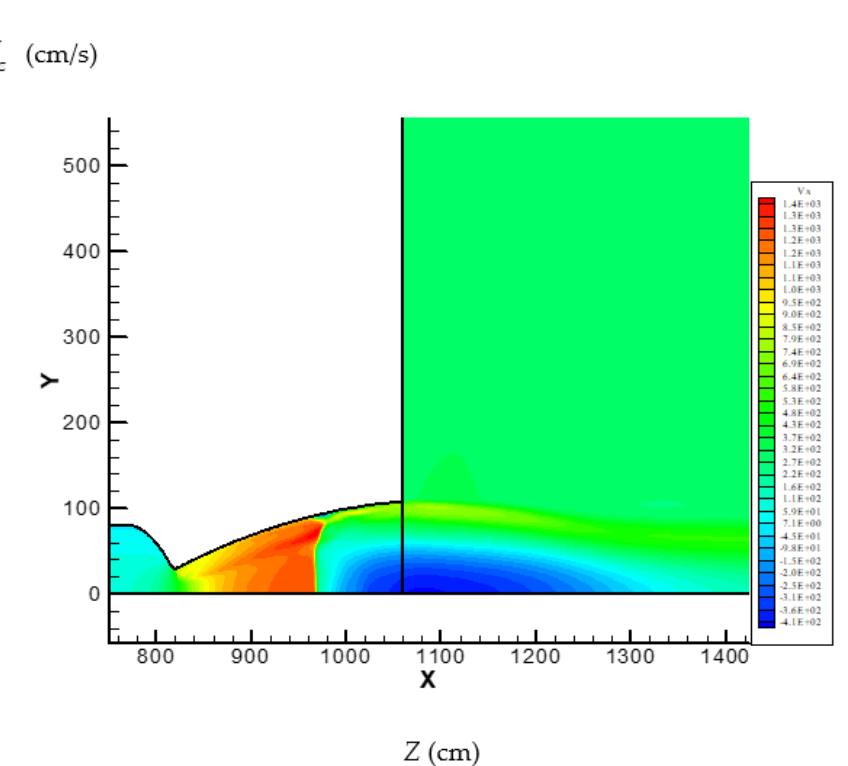
Figure 6. Spatial distribution of the longitudinal velocity in the combustion products and the wake air (Navier–Stokes equations, “elliptical” shape of the nozzle, h = 6 km).